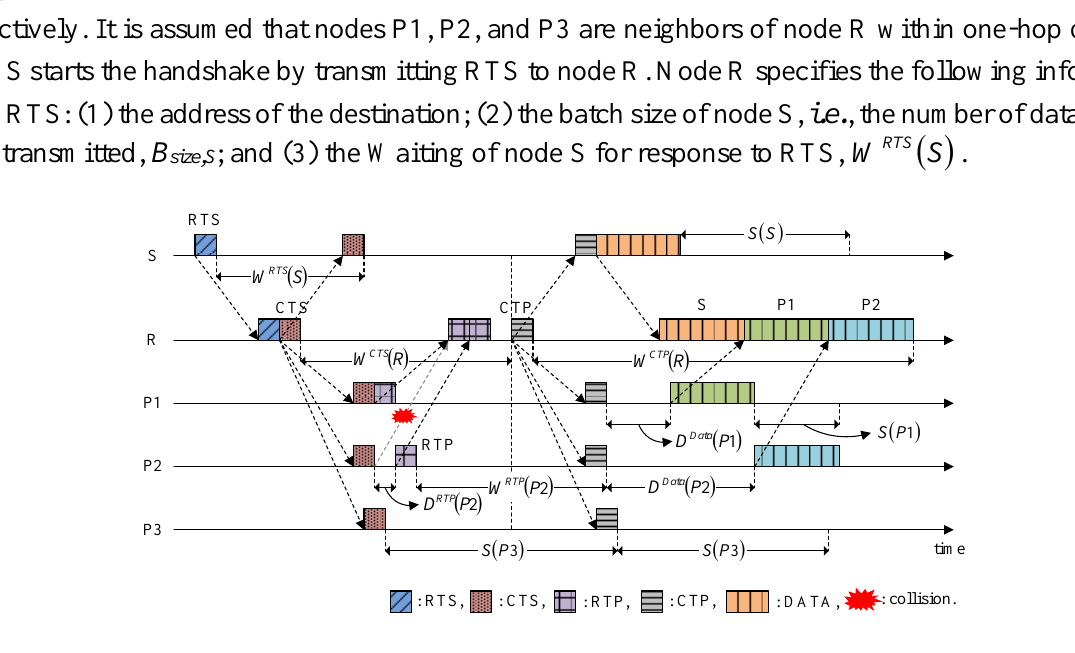
Figure 4. Operation of the HSR